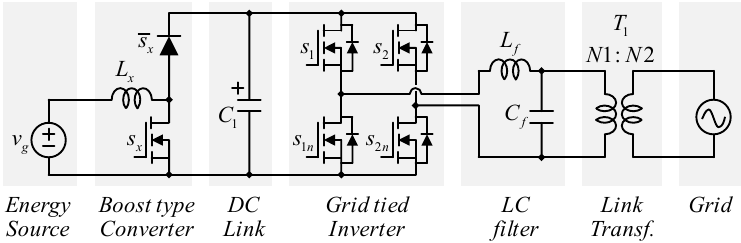
Figure 1. Possible configuration of a renewable energy generation system.